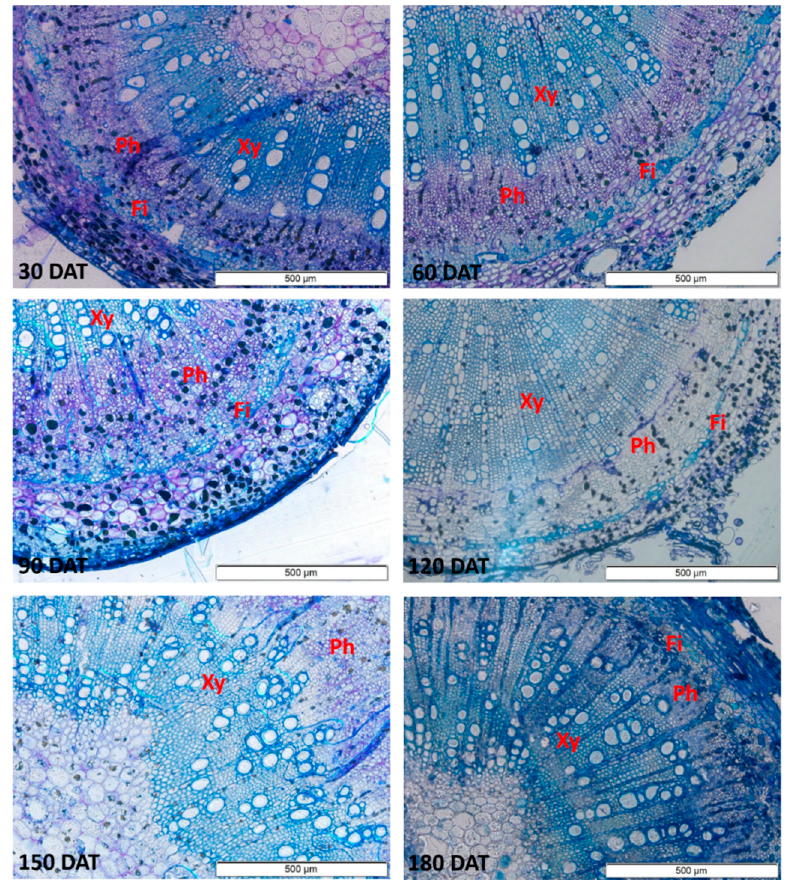
Figure 4. Sections of the stem of the seedlings of Hymenaea courbaril L. cultivated in a hydroponic system, showing the different anatomical features (Xy = Xylem; Ph = Phloem; Fi = Fibers). Sections obtained at 30-day intervals across the initial development of the plants (30, 60, 90, 120, 150, and 180 days after transplantation).